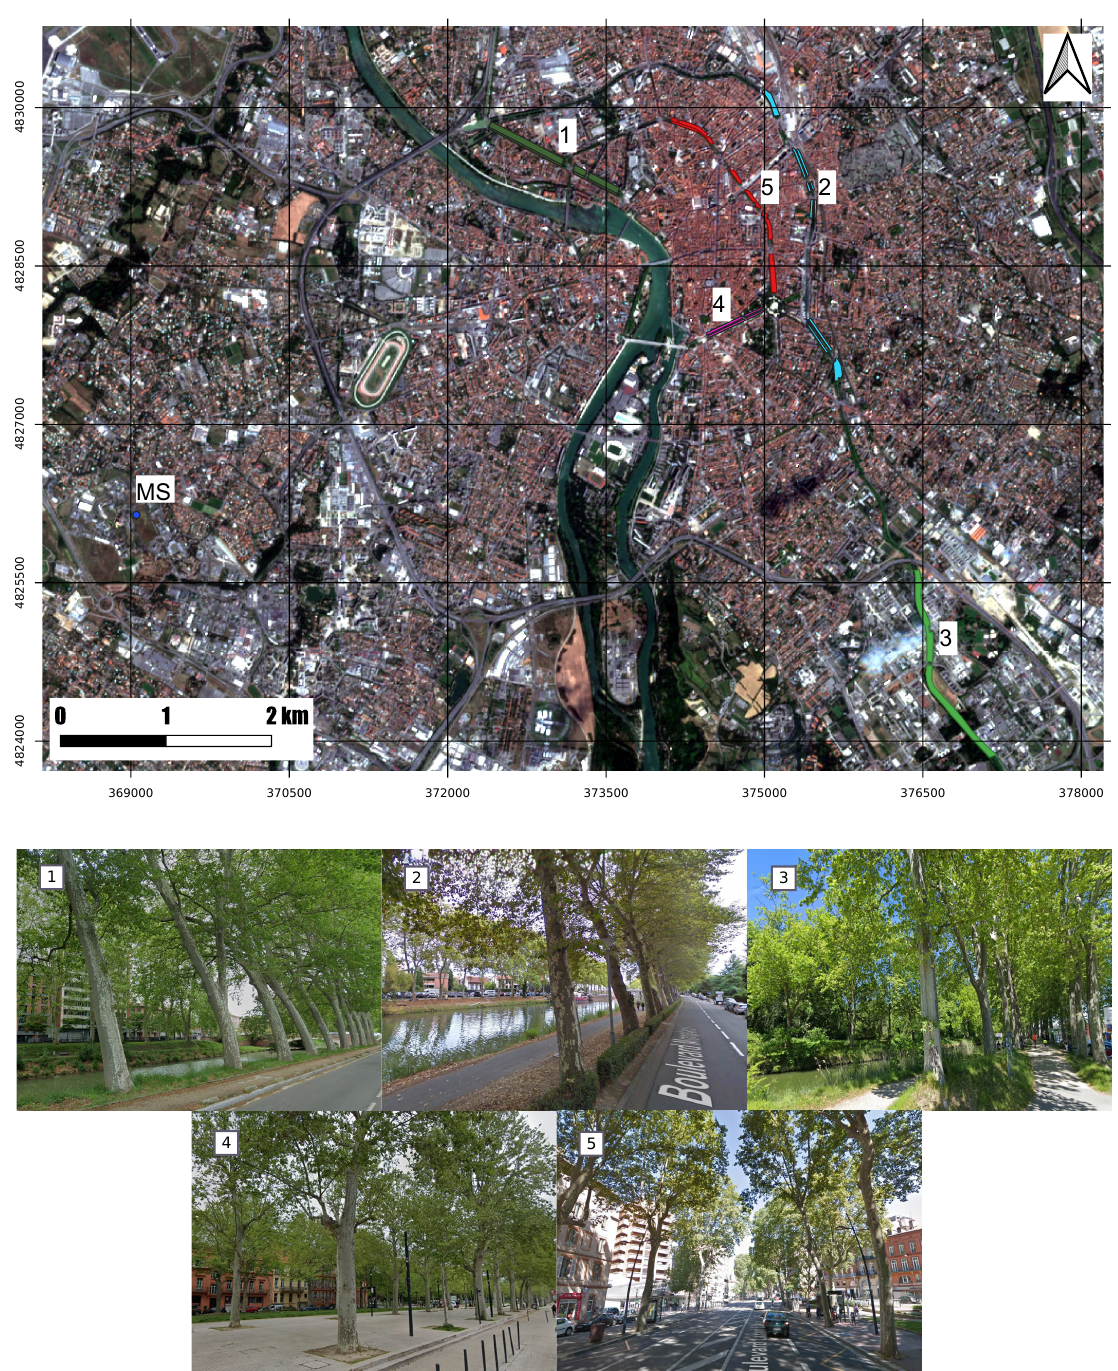
Figure 1. Above: Toulouse (France) Sentinel-2 Red Green Blue (RGB) composite image. The masked areas correspond to: (1) Canal de Brienne (dark green), (2) Urban Canal de Midi (Cyan), (3) Peri-urban Canal de Midi (light green), (4) J. Guesde Avenue (Magenta) and (5) F. Verdier Avenue (Red). The blue point with the label MS indicates the location of the meteorological station. Below: Google “Streetview” digital images from April 2019 (Brienne), May 2014 (MiDi Int), May 2019 (MiDi Ext), May 2015 (JGuesde) and July 2016 (FVerdier) are used to illustrate the